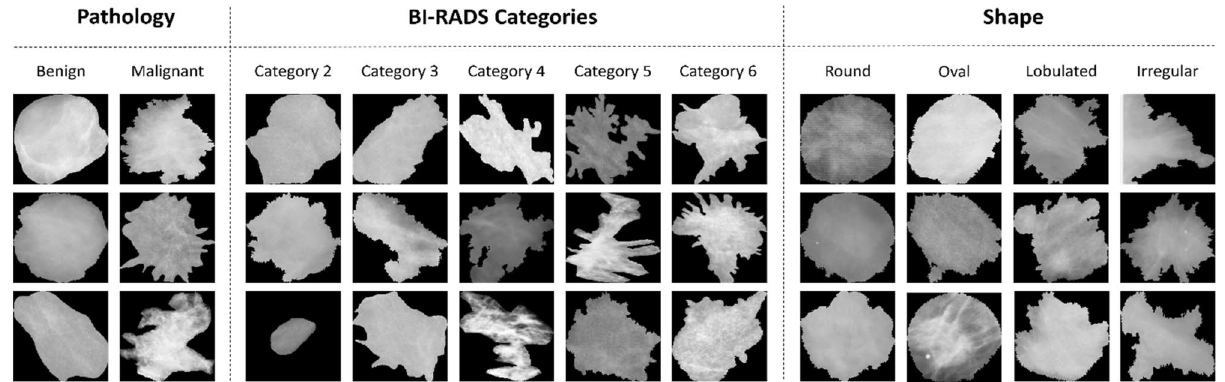
Figure 5. Samples of detected and segmented ROI masses for each class within different classification tasks from different mammography datasets.